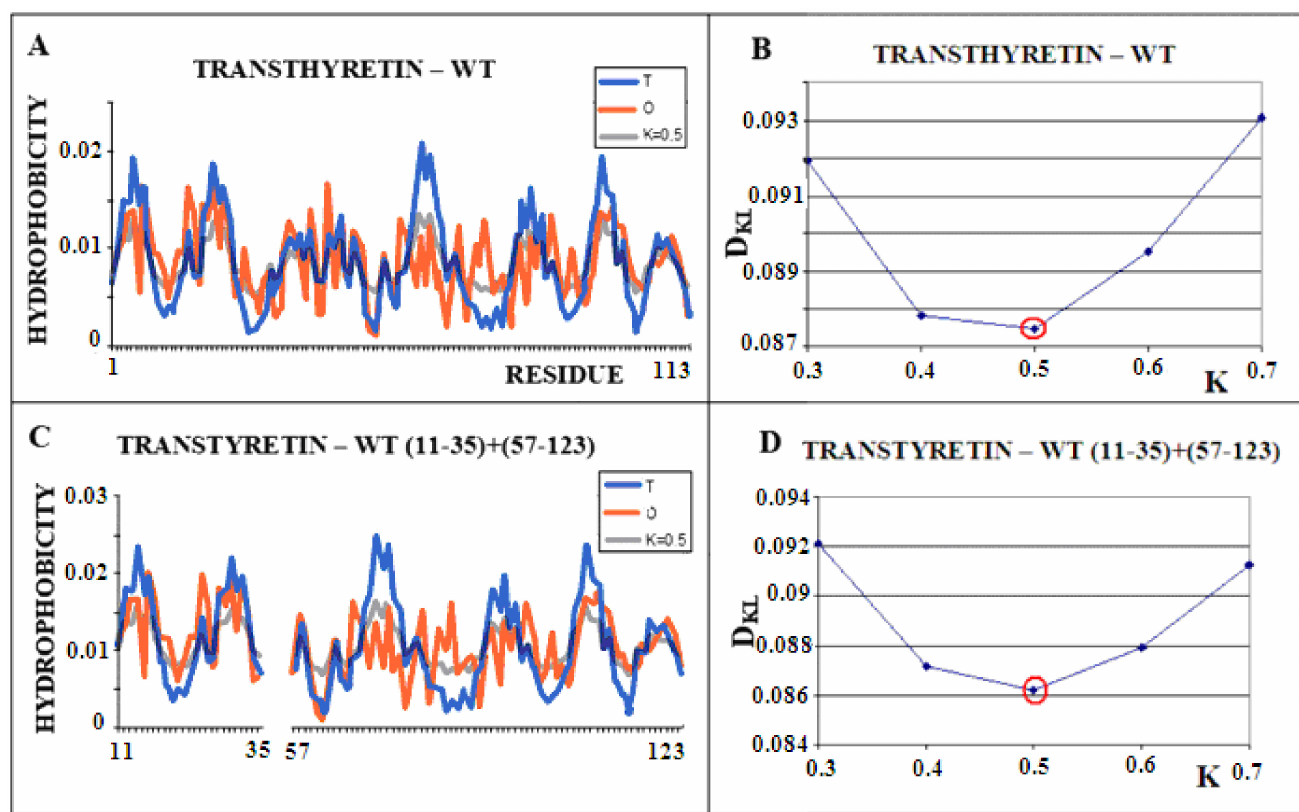
Figure 2. Structural characteristics of transthyretin. ( A )—T-navy blue, O-red, and M-gray profiles for the complete chain. The M distribution is obtained for the parameter K = 0.5 according to B. ( B )—Change in the D KL value for the O–M relation with different values of the K parameter. The lowest value was indicated as representing the shortest distance between the distribution of O and M. ( C )—T-navy blue, O-red, and M-gray profiles for WT form of transthyretin however limited to fragments present in the amyloid form of this protein. The M distribution is obtained for the parameter K = 0.5. according to D. ( D )—Change in the D KL value for the O–M relation with different values of the K parameter. The lowest value was indicated as representing the shortest distance between the distribution of O and